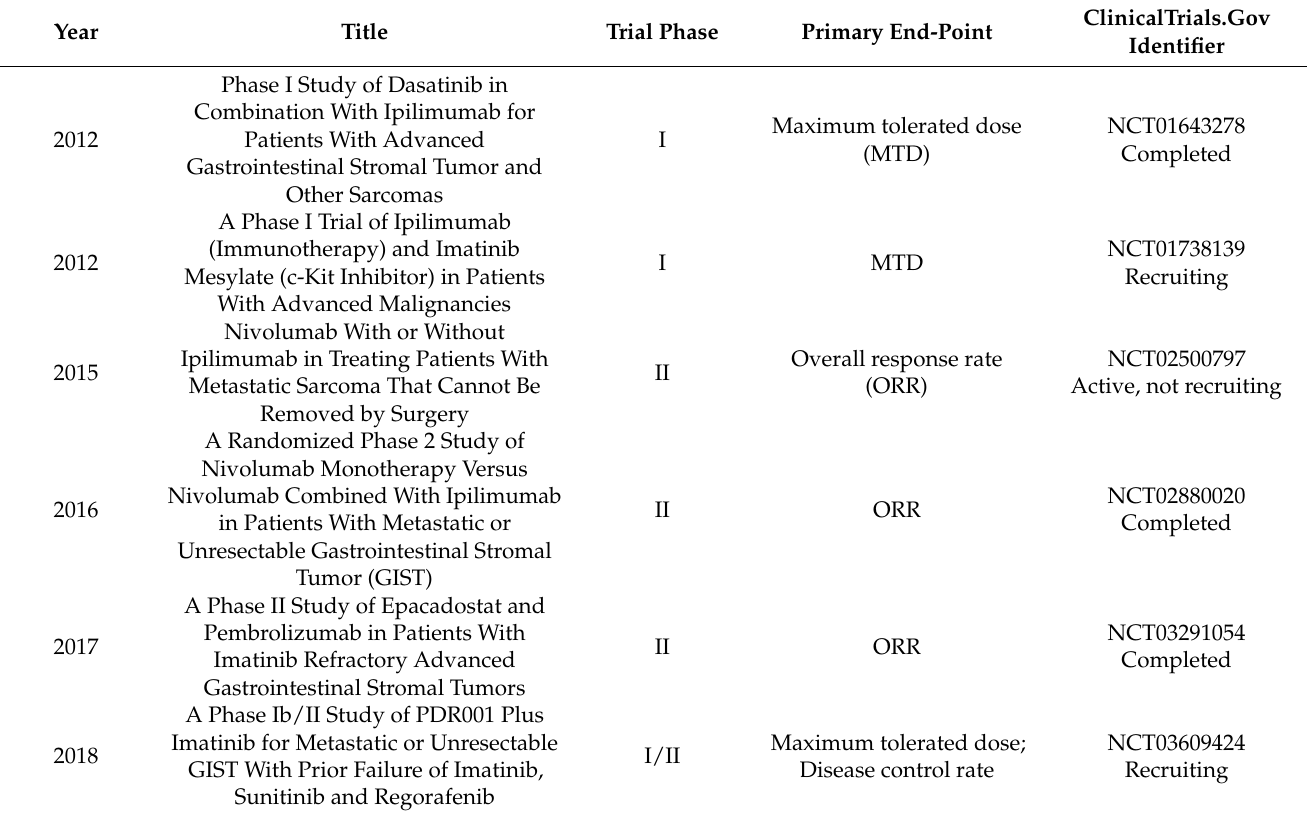
Table 1. Clinical Trials of Immunotherapy in